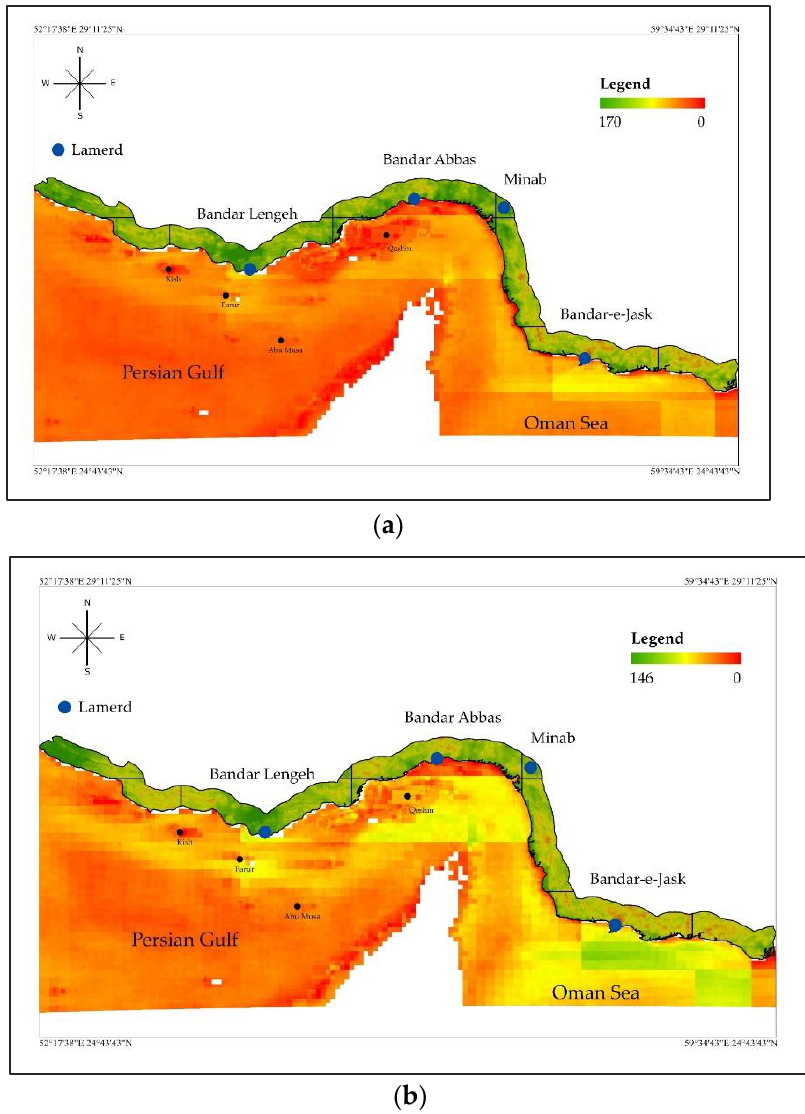
Figure 5. The results of using ( a ) equal weight (Sc1) and ( b ) Deweiri et al. weighting method (Sc2) [18].